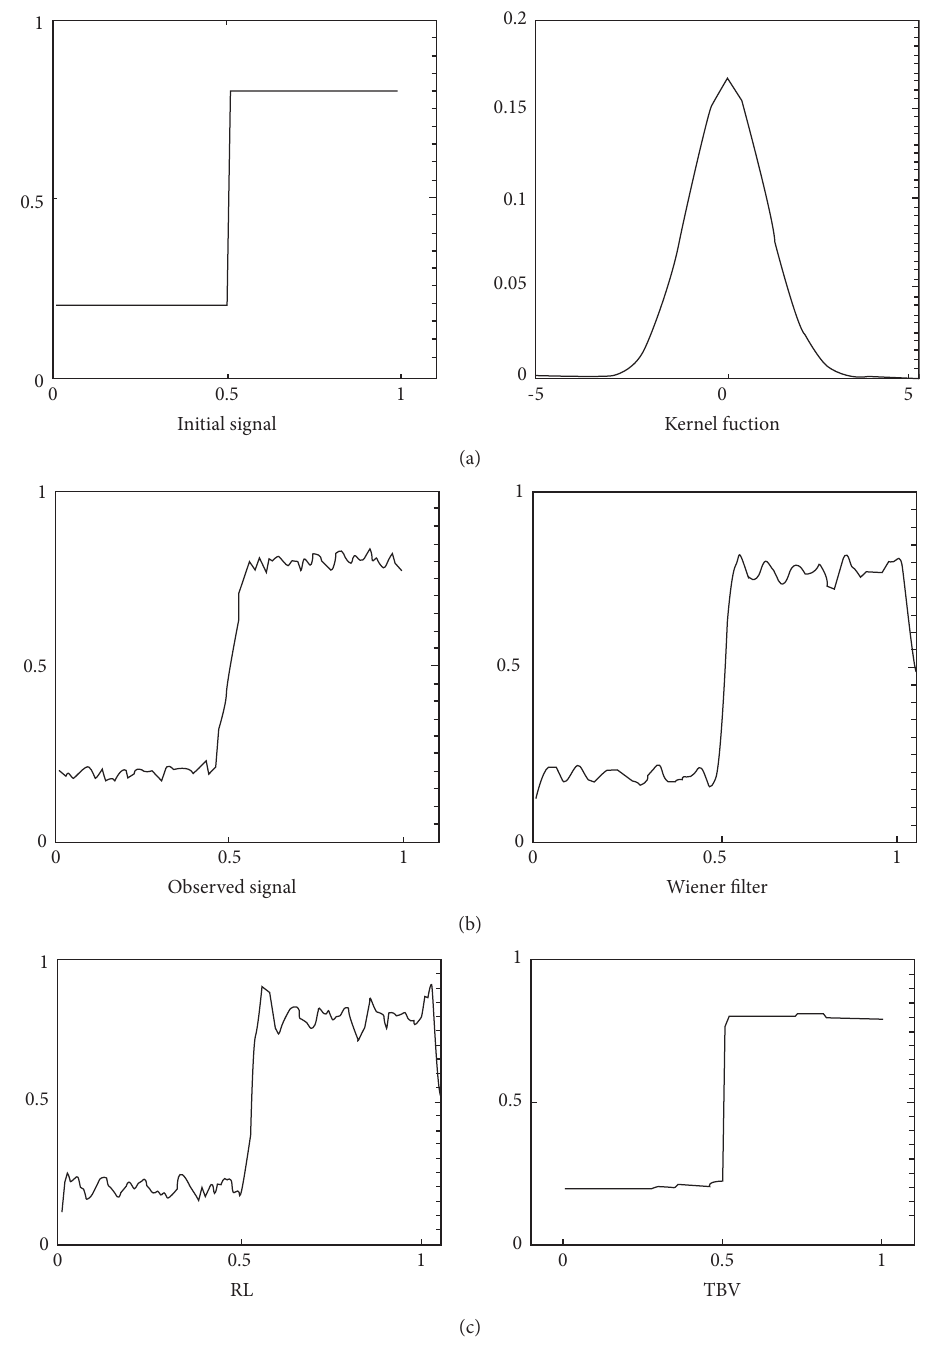
Figure 5: Signal restoration comparison chart: SNR � 30dB and TBV parameter μ � 1.